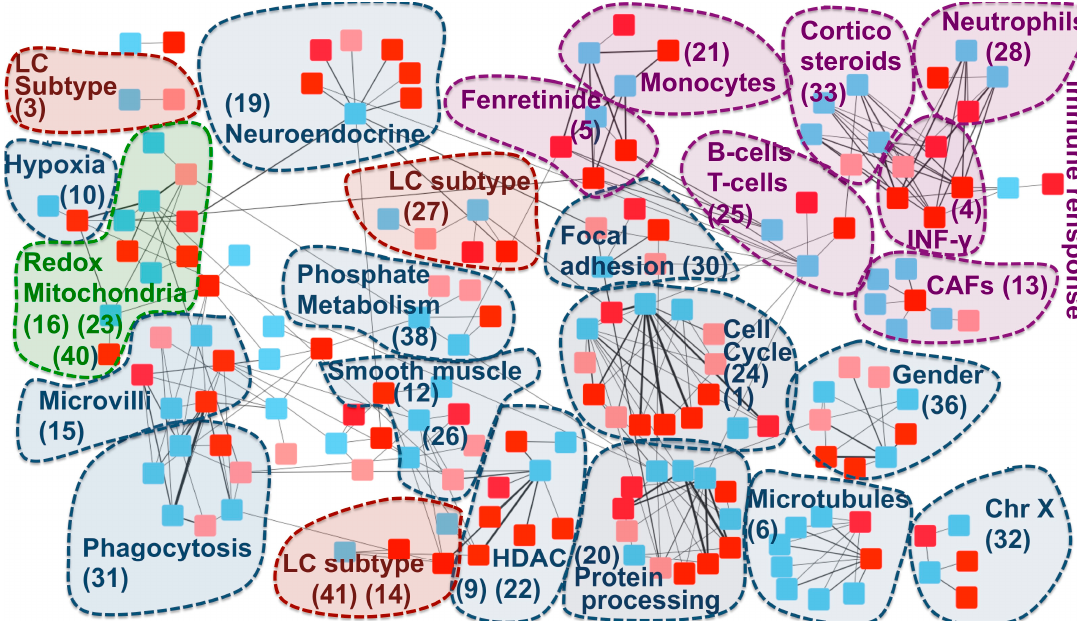
Figure 4. –RBH AD/LC subnetwork with biological annotations. Each node in the network corresponds to a metagene; the list of metagenes associated to each community ID is reported in Supplementary Table S3. Colours are linked to the diseases: red for AD and blue for LC. In AD, datasets obtained from the same region of the brain are denoted with different shades of red (normal and light red). The nodes are organized into communities. Each community is denoted with a number corresponding to its ID and the main biological annotation associated to them (see Supplementary Table S2 for an extensive report). HDAC = histone deacetylase.